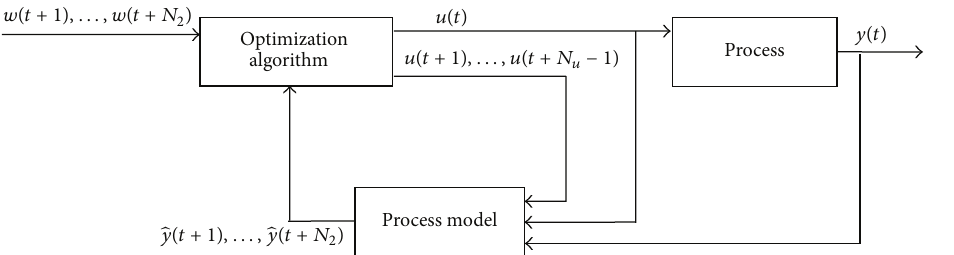
Figure 1: Basic structure of MPC